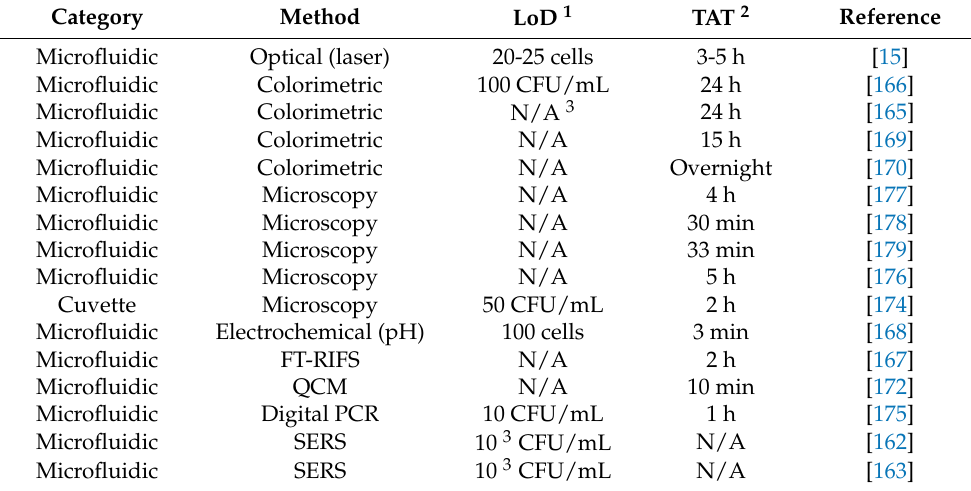
Table 3. Microfluidic platforms described in the